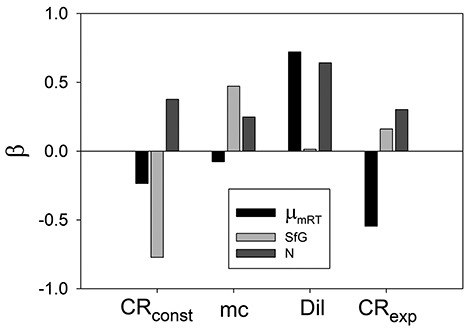
Regression statistics for Phyto chemostat. Data are from the simulations shown in Fig. 3. Shown are values of standardized regression coefficients (β values) for linear regression of the output variables maximum growth rate at the reference temperature (μmRT), SfG and residual nutrient (N) on the parameters along the X-axis and which also feature in the mesh plots of Fig. 3.